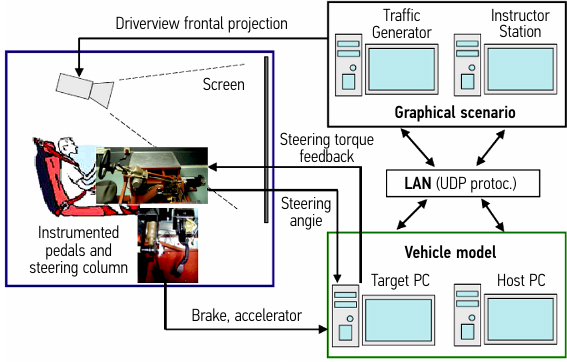
Fig. 4. Block Scheme of the driving